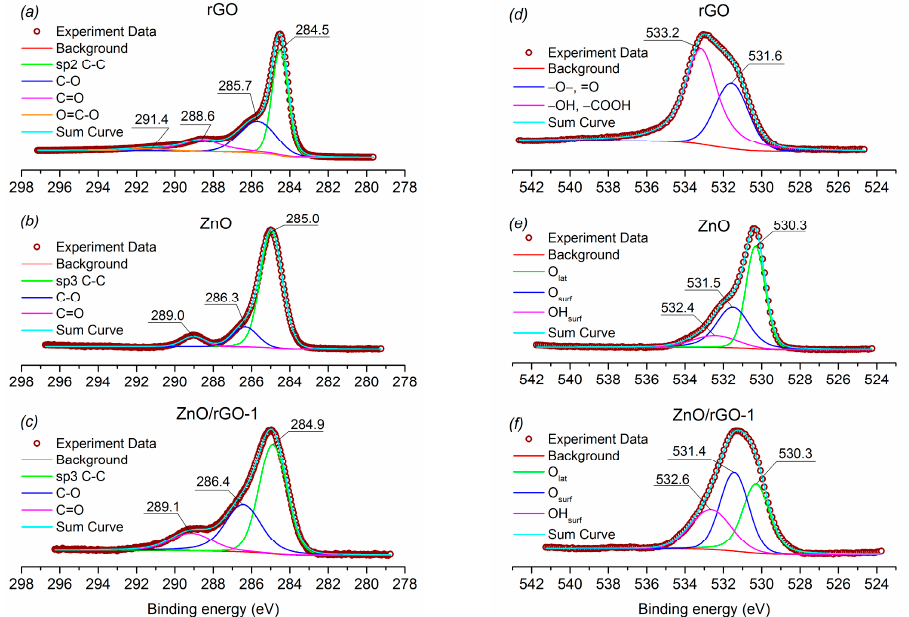
Figure 5. XP-spectra in C1s ( a – c ) and O1s ( d – f ) regions of rGO nanosheets ( a , d ), ZnO nanofibers ( b , e ) and ZnO/rGO-1 nanocomposite ( c , f ).